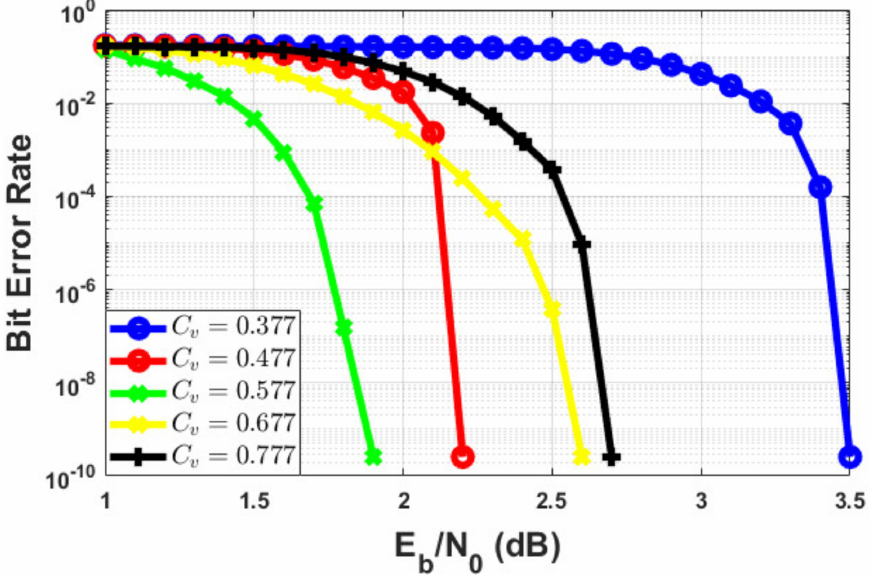
Figure 6. Polar code BER versus E b / N 0 for code rate R = 3/5 and different coefficient of variation C v